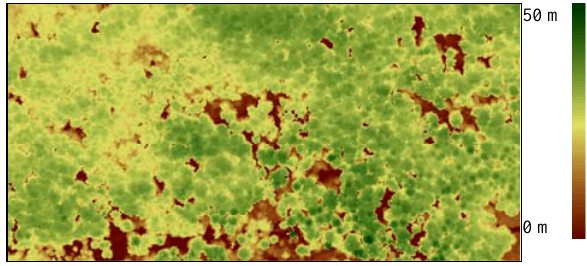
Figure 2. Canopy Height Model (CHM) of the study site. The DSM was used for retrieving the shaded/sunlit areas in the forest by exploiting a simple ray tracing algorithm and exact sun position in the IS data acquisition time.